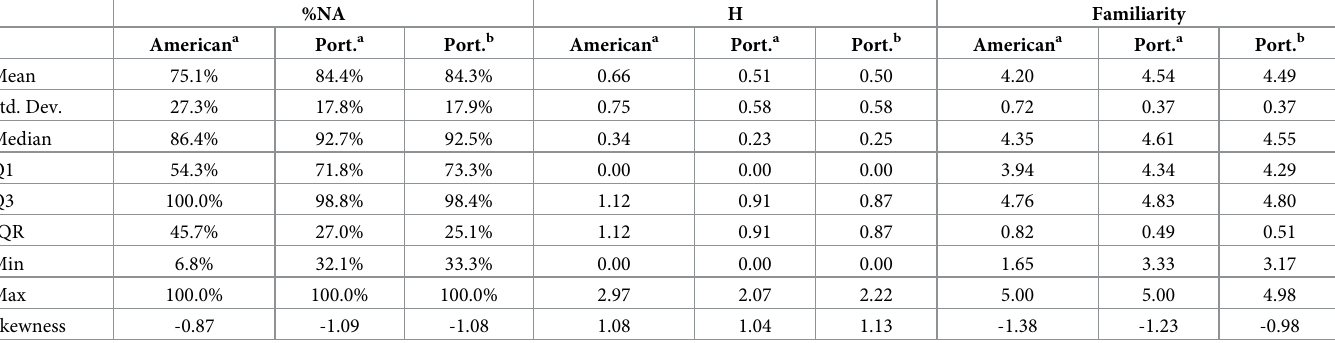
Table 1. Summary statistics for the name agreement scores (%NA and H values) and familiarity ratings, given by the North American and the two Portuguese samples.